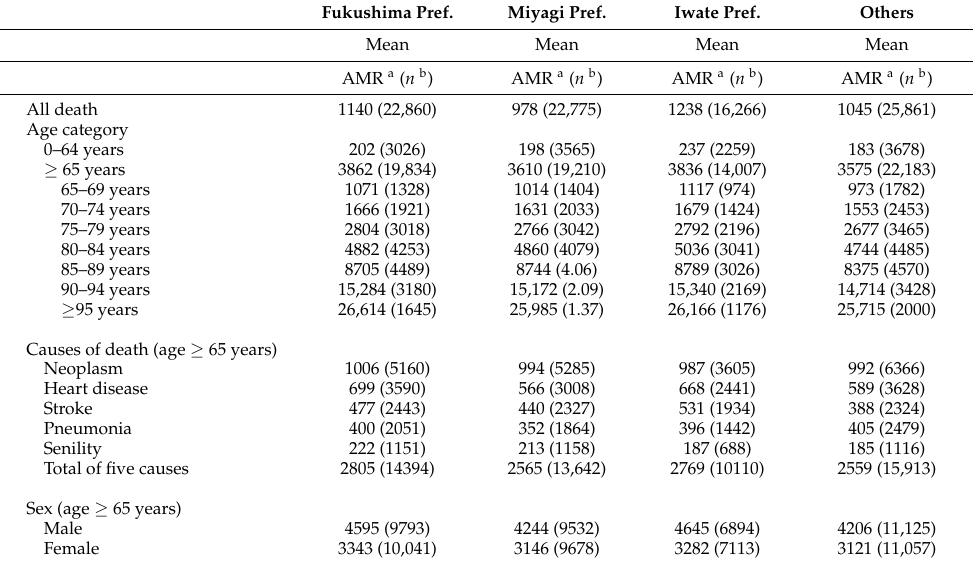
Table 1. Characteristics of the death data from 2006 to 2015. Fukushima Pref. Miyagi Pref. Iwate Pref.